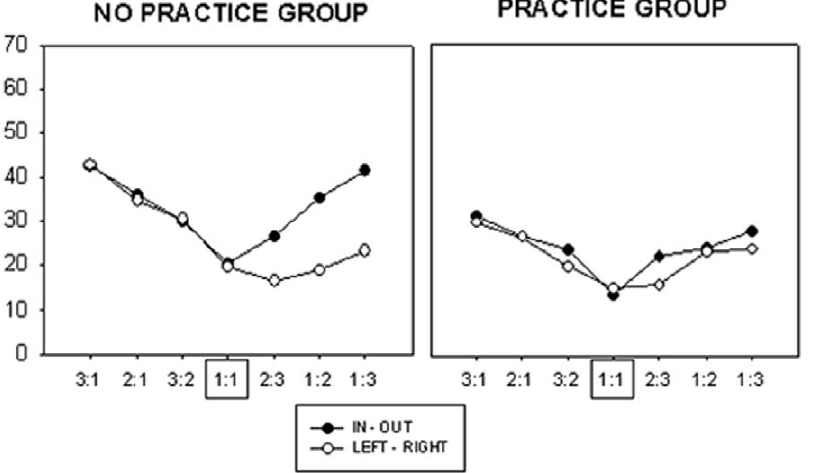
Figure 4. Three-factor interaction of finish offset error for Group, Direction, and Frequency Ratio. The ‘seagull’ pattern is clear when the direction required is inward or outward. However, when the required direction is left or right, an asymmetrical pattern emerges. When the dominant right hand was required to rotate faster, the finish offset error was smaller than when the non-dominant left hand was required to lead.